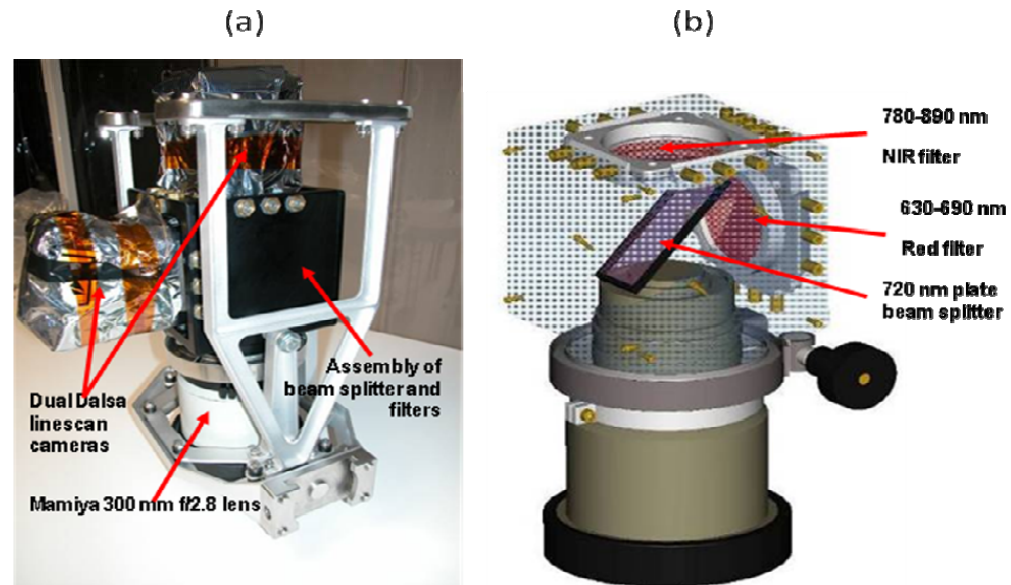
Figure 1. Electro-optical components of AgCam. (a) components integrated in vibration isolation and absorption frame, and (b) computer-aided-design model of internal optical beamsplitter and trim